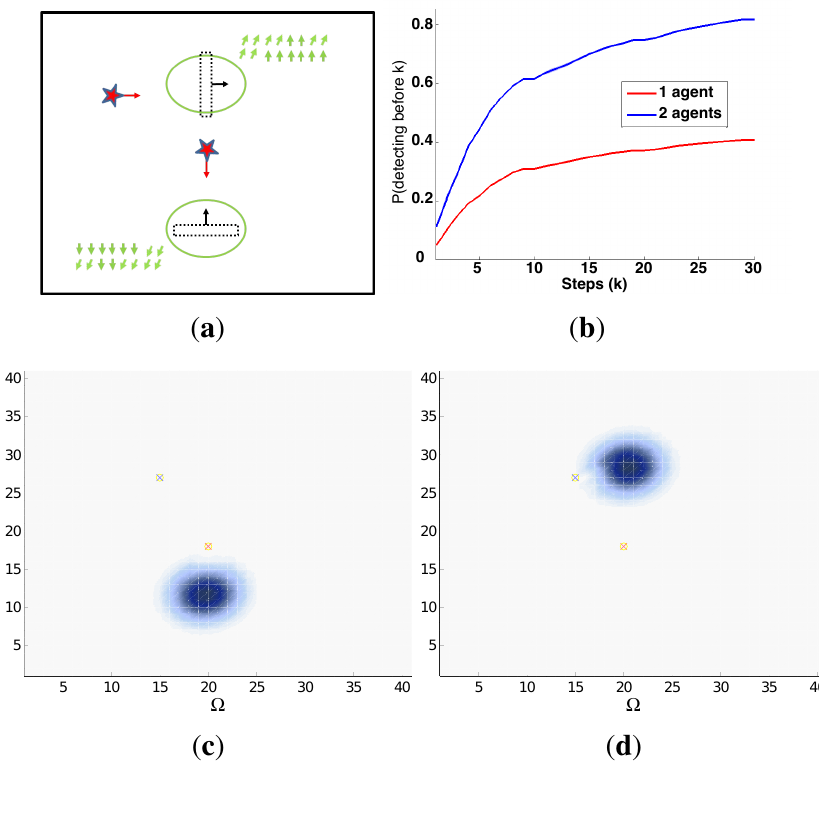
Figure 15. Properties and IG curves of the dynamic camera scenario. ( a ) Scenario; ( b )